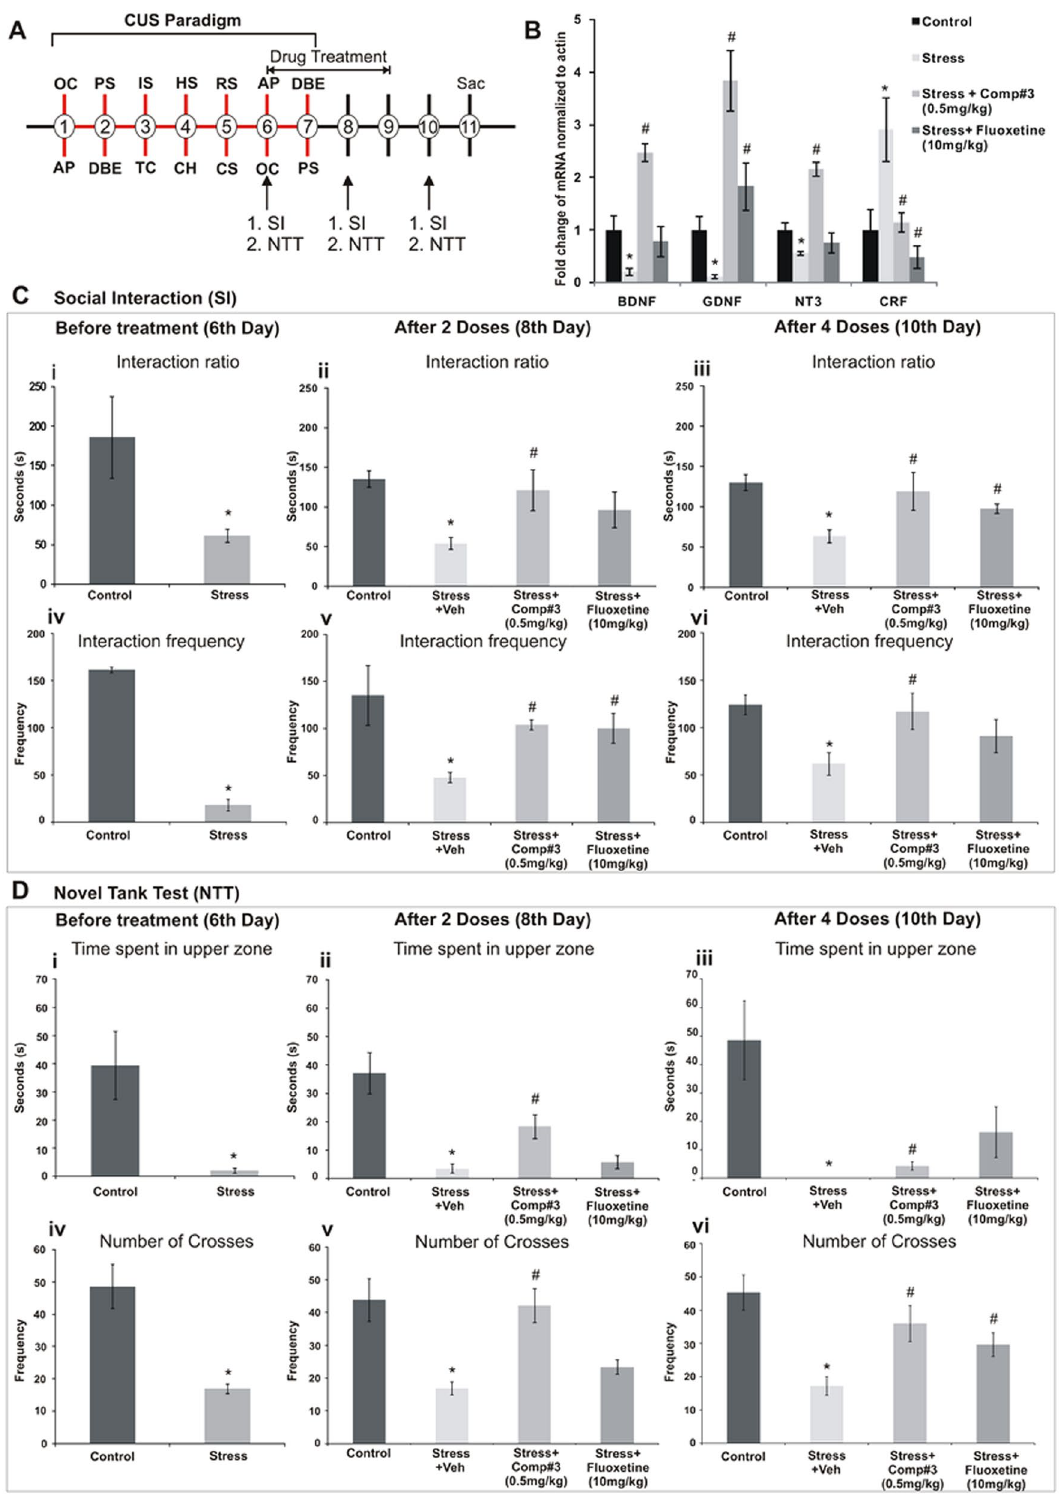
Figure 5. Antidepressant assay in adult zebrafish: CUS-induced behavioural compromise and altered neurotrophic profile. Schematic representation of the paradigm ( A ). Effect of the #3 and fluoxetine treatments on the social interaction test ( C ), Novel tank test ( D ) and mRNA levels of the neurotrophic factors ( B ). OC- Over Crowding, AP- Alarm Pheromone, PS- Predator Stress, DBE- Dorsal body exposure, IS- Isolation Stress, TC- Tank Change, HS- Heat Stress, CH- Chasing, RS- Restrain Stress, CS-Cold stress, SI- Social Interaction, NTT- Novel tank test. Values are represented as mean ± SE with n = 3; p ≤ 0.05 indicates significant post hoc differences between control vs stress group represented by ( * ) and stress vs treatment groups, while represented by ( # ) by two-tailed student’s t-test. (n =